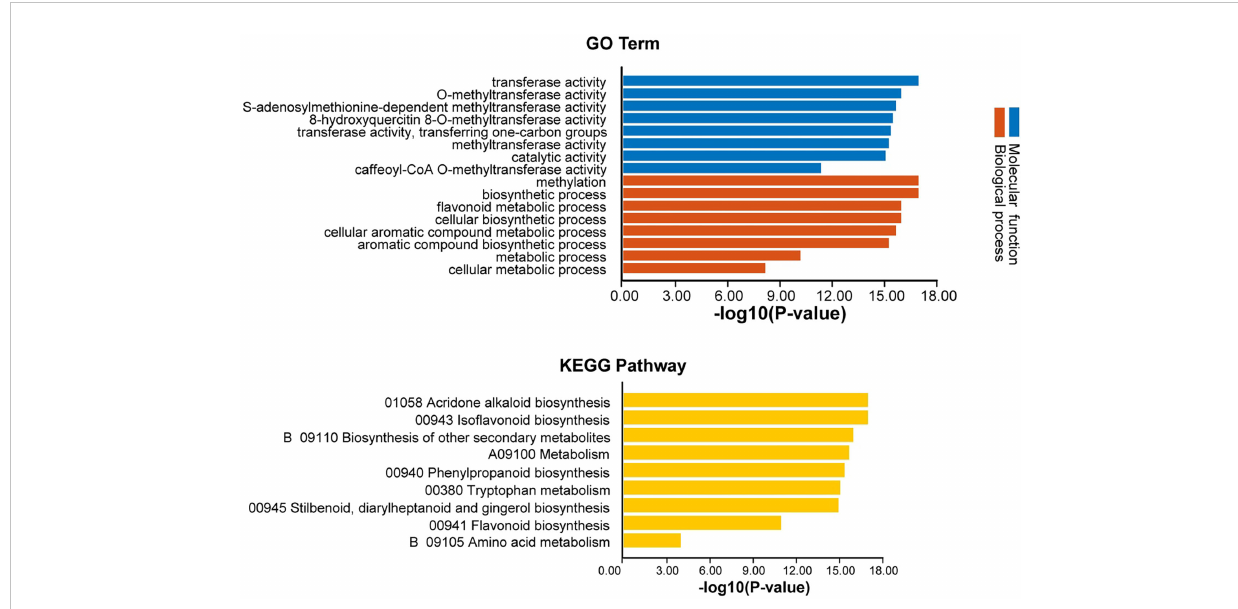
FIGURE 11 Functional annotation (GO, KEGG) analysis of AhOMTs . The gene ontology analysis showed that AhOMTs are involved in molecular function (MF), and biological processes (BP). The KEGG enrichment analysis showed that AhOMTs are mainly involved in metabolic